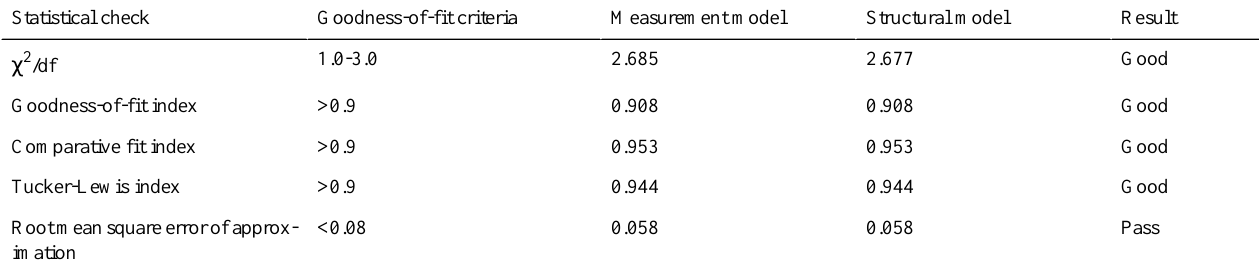
Table 5. Goodness of fit of the measurement and structural